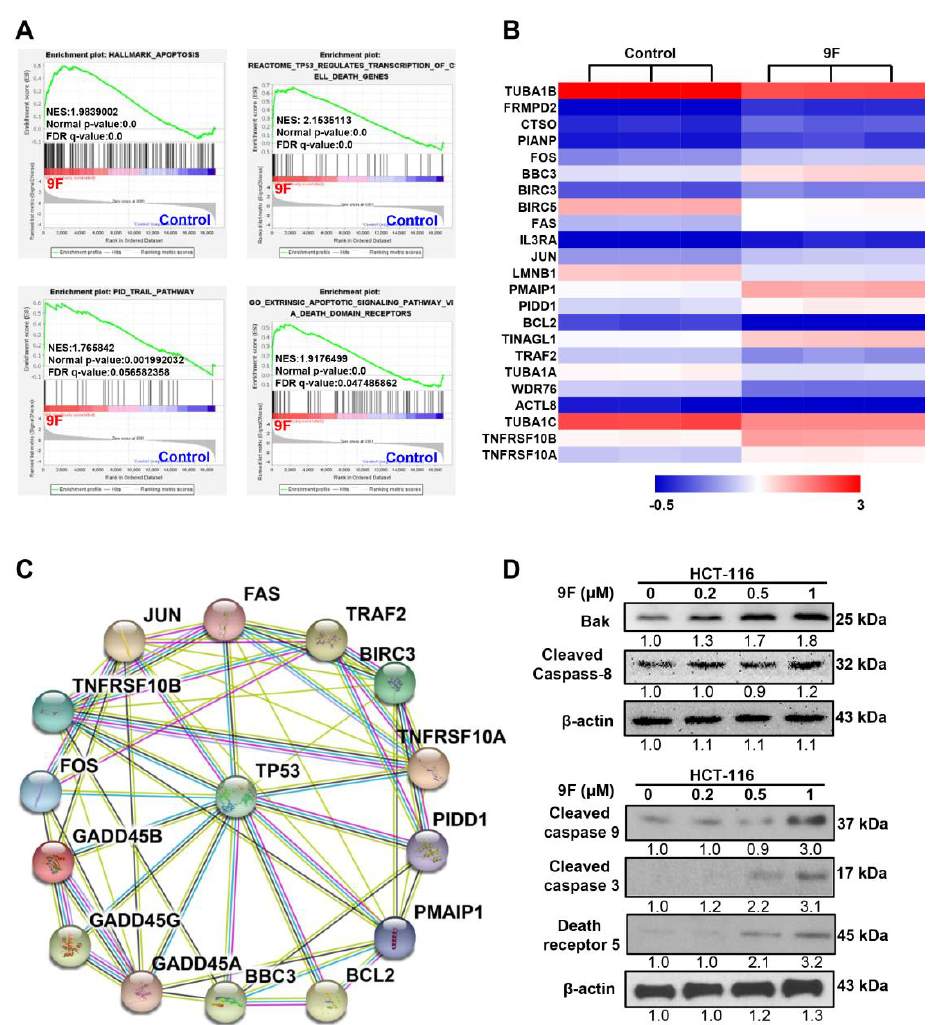
Figure 4. Activation of intrinsic and extrinsic apoptosis pathways accounted for 9F-induced cell death. ( A ) GSEA plots correlating with apoptosis, p53 regulates transcription of cell death genes, TNF-related apoptosis-inducing ligand (TRAIL) pathway and extrinsic apoptotic signaling pathway via death domain receptors. ( B ) Heatmap of differentially expressed genes involved in apoptosis. ( C ) Protein-protein interaction (PPI) network based on Search Tool for the Retrieval of Interacting Genes (STRING) showing the detailed interactions of p53 and cell death-related proteins. ( D ) Western blot analyses of Bak, cleaved caspase 8, cleaved caspase 3, cleaved caspase 9 and death receptor 5 following 9F treatment for 48 h.